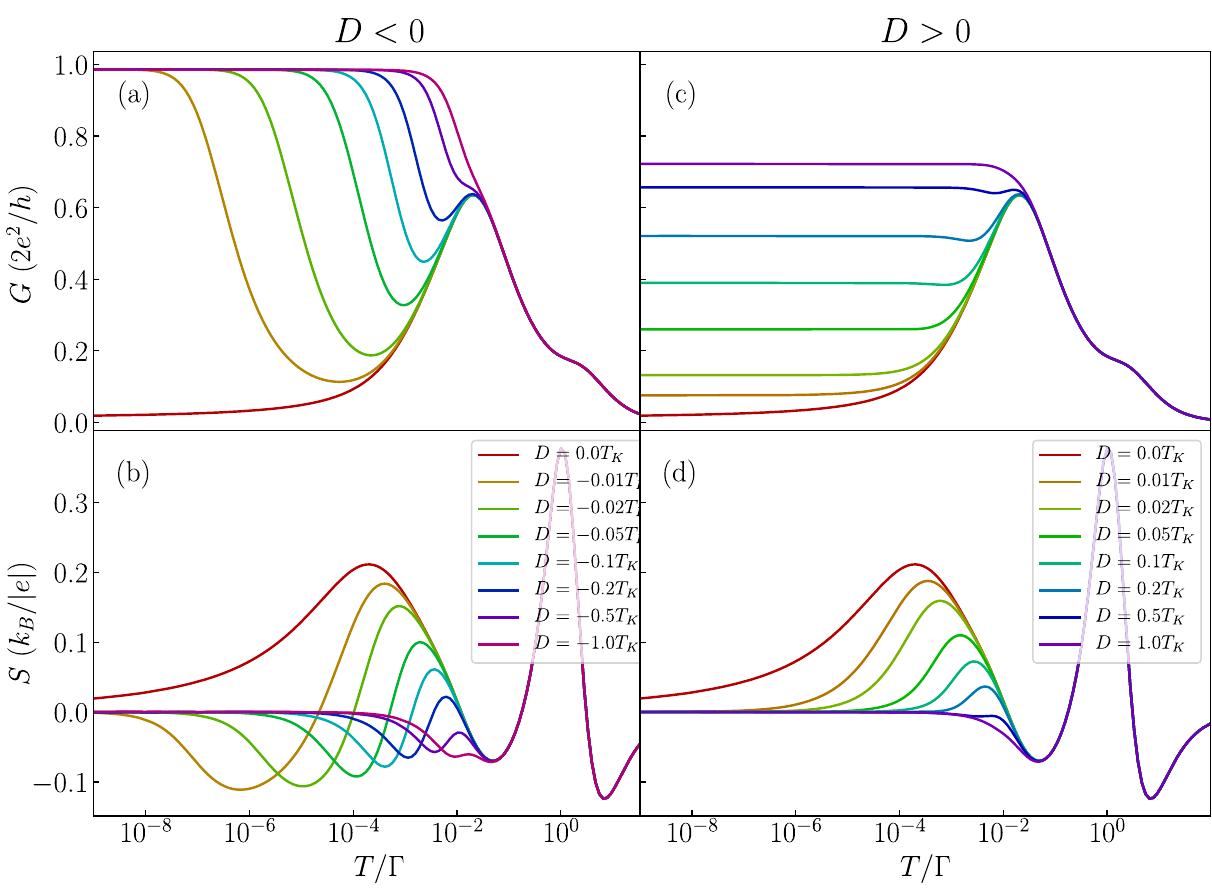
Figure 4. The effect of magnetic anisotropy in the case of molecule with nonmagnetic contacts. The temperature dependence of ( a , c ) the conductance and ( b , d ) the Seebeck coefficient in the case of antiferromagnetic exchange interaction J = − T K for selected values of magnetic anisotropy D . The left (right) column presents the case of easy-plane (easy-axis) type of magnetic anisotropy. The parameters are the same as in Fig. 2 with ε = − U / 3